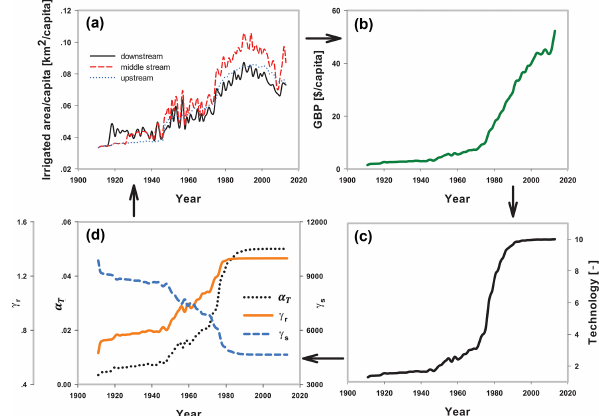
Figure 8. Time variation of socio-economics: (a) irrigated area per capita for each of the three settlements; (b) gross basin product in $/capita; (c) crop yield γ r , crop water demand γ s and the technology factor α T ; and (d) technology T .